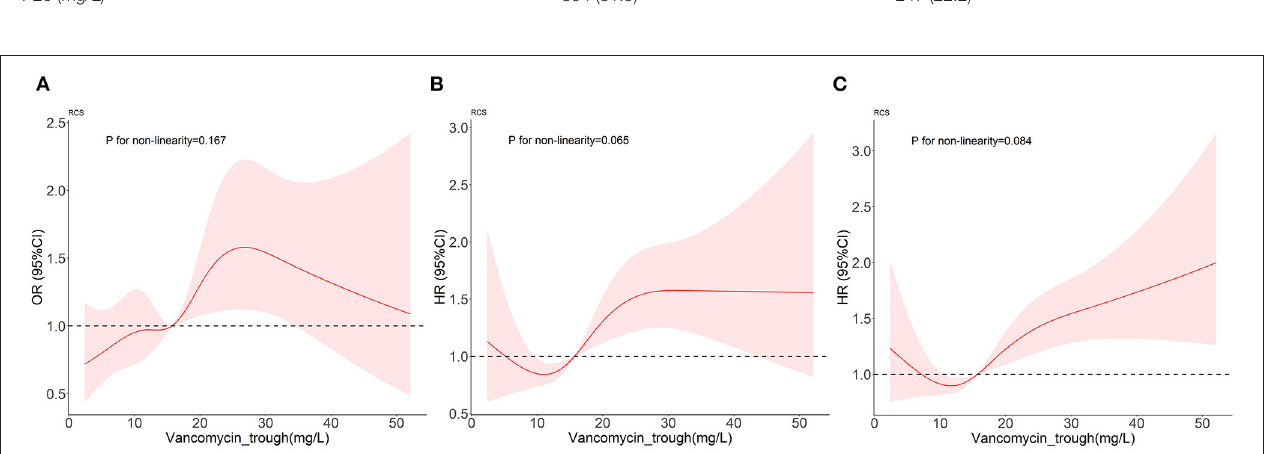
Frontiers in Medicine |